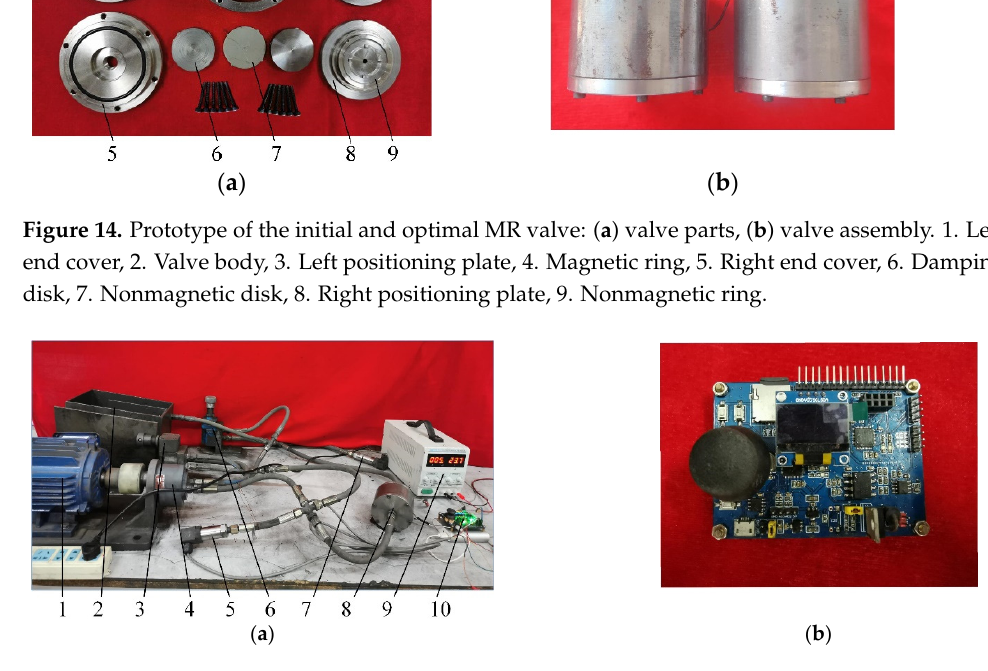
Figure 16. Pressure change of the optimal MR valve under different currents.